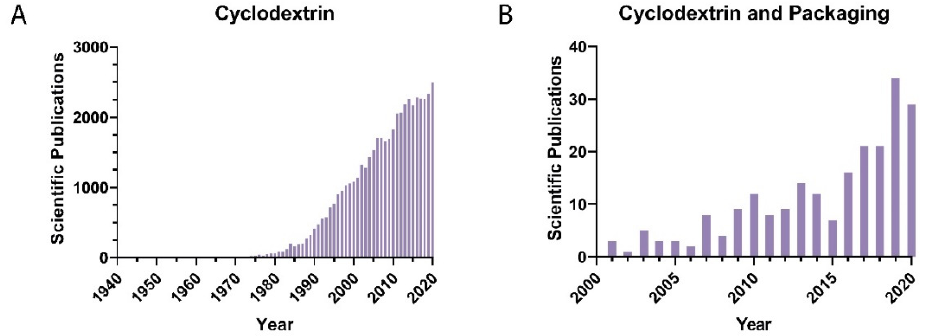
Figure 2. Evolution of scientific publications per year by searching in the Scopus database using the keywords ( A )“Cyclodextrin” and ( B ) “Cyclodextrin and